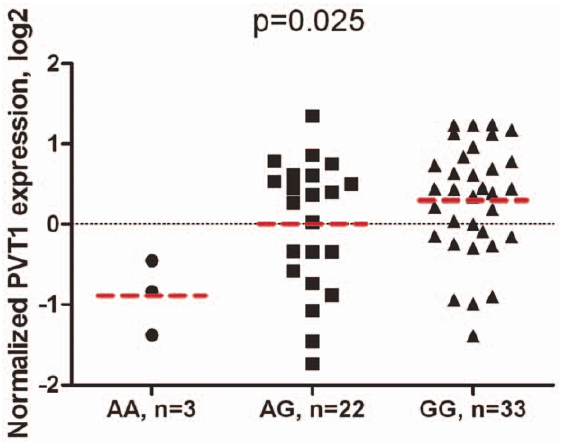
Figure 4. Association of PVT1 gene expression with rs378854 genotype in 59 normal prostate samples. P-values are for univariate linear regression analysis of PVT1 expression in relation to 0, 1 and 2 risk allele (G) of rs378854, adjusted for race. Expression values are shown on log2 scale relative to a mean value of all samples. Expression is lowest in carriers of non-risk AA genotypes and highest in carriers of risk GG genotypes. Mean expression values of each group are shown as